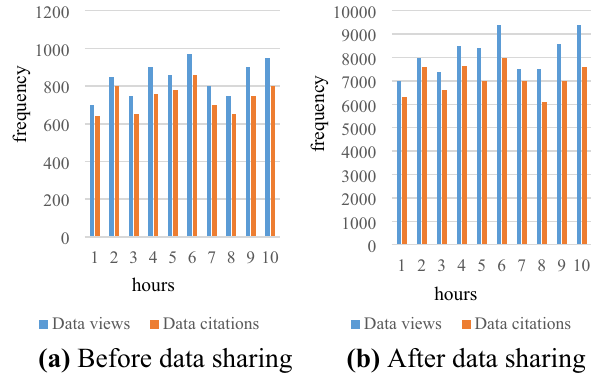
Fig. 10 Data sharing degree